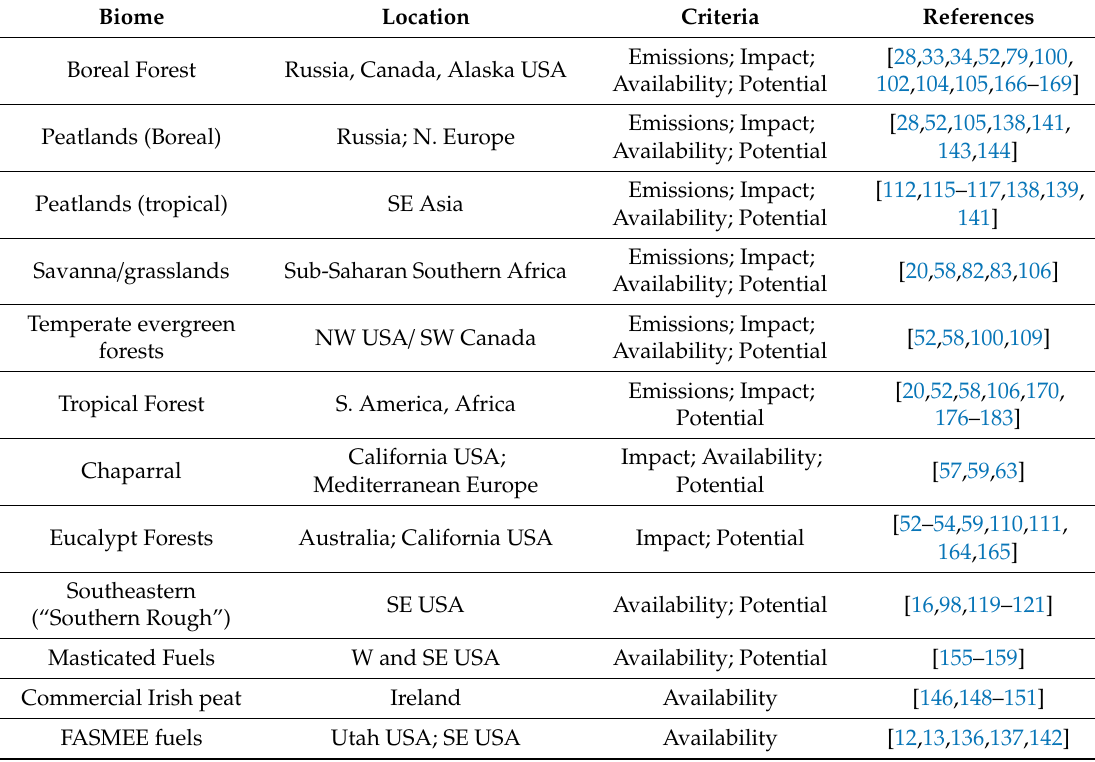
Table 5. The wildland fuels listed below represent the application of multiple criteria (Emissions, Impact, Availability / Uncertainty, and